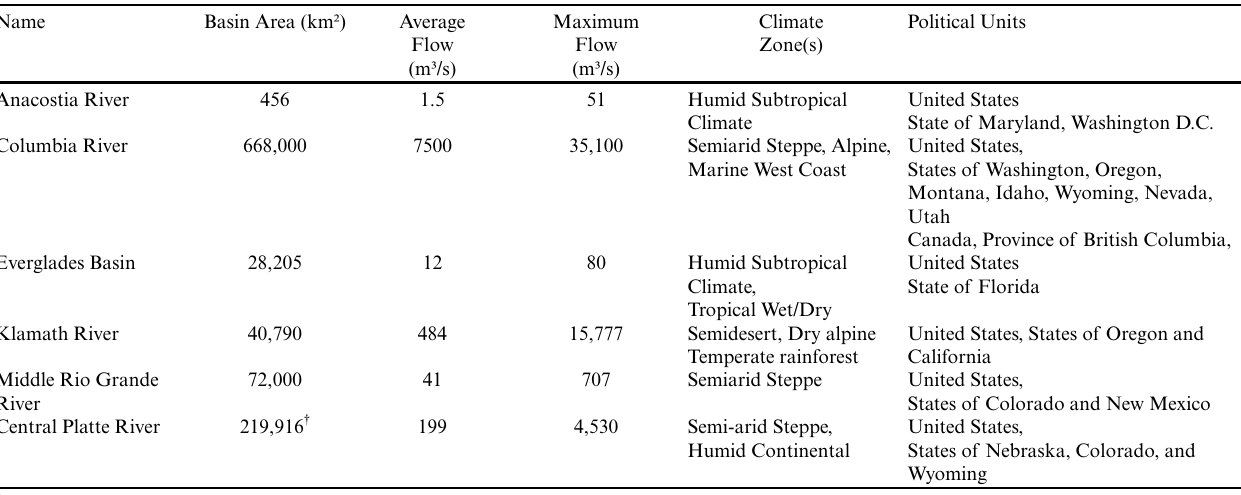
Table 1 . Characteristics of hydrologic basins in the United States used as case studies in assessing adaptive capacity, ecological resilience to rapid environmental